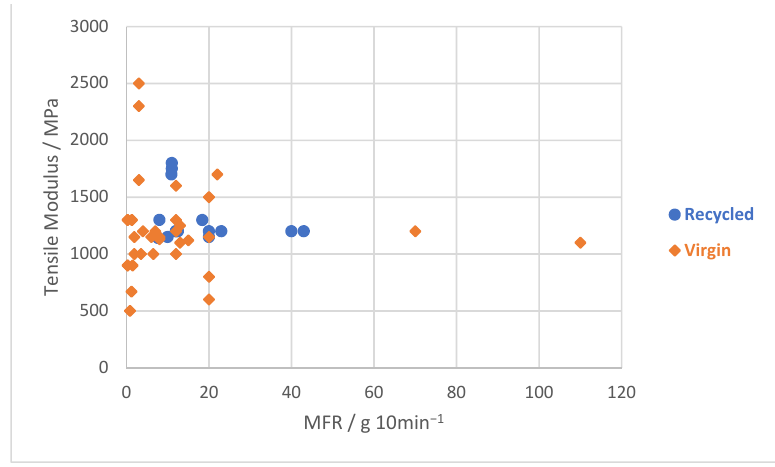
Figure 6. Tensile modulus and MFR values of R-PP and V-PP.